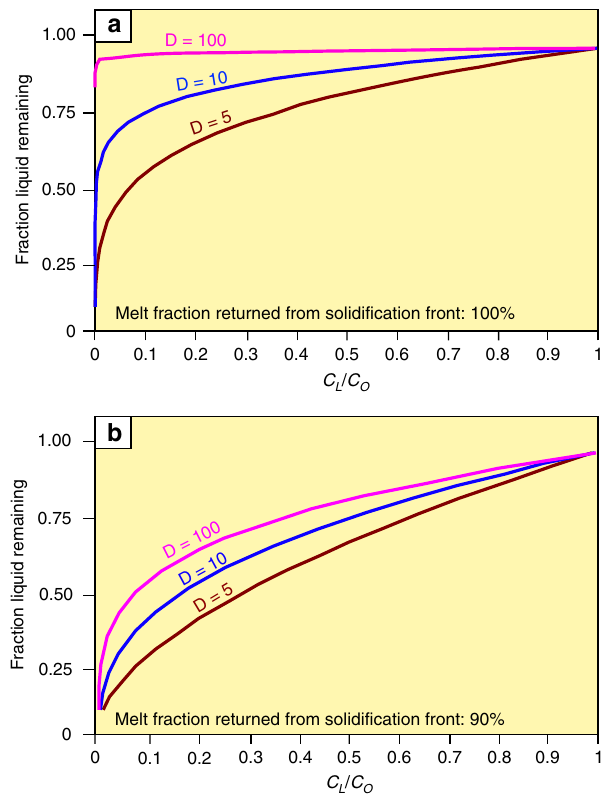
Fig. 8 The comparative behaviour of compatible trace elements in magmatic systems with perfect and imperfect liquid fractionation. During the crystallization of magma, compatible trace elements are rapidly depleted as the fraction liquid remaining decreases. a If perfect crystal- liquid occurs, the rate at which trace elements are depleted are most rapid, and magmatic differentiation is most effective. The varying rates of depletion is shown for three trace elements with varying values of D (5, 10, and 100). b In this case, the fractionation of crystals and liquid is imperfect and 10% of the rejected liquid remains within the solidi fi cation front. This dramatically slows the rate of depletion of compatible elements with the effect being more dramatic for elements with higher compatibilities. This causes different trace elements with different compatibilities to behave more similar. Thus, to best describe the more constant V concentration compared with the extremely rapid depletion of Cr in magnetitite from the Bushveld Complex (Fig. 7), the crystal-liquid fractionation needs to be near- perfect (Methods). C L : Concentration of a particular trace element in the liquid. C O : Initial concentration of a particular trace element in the